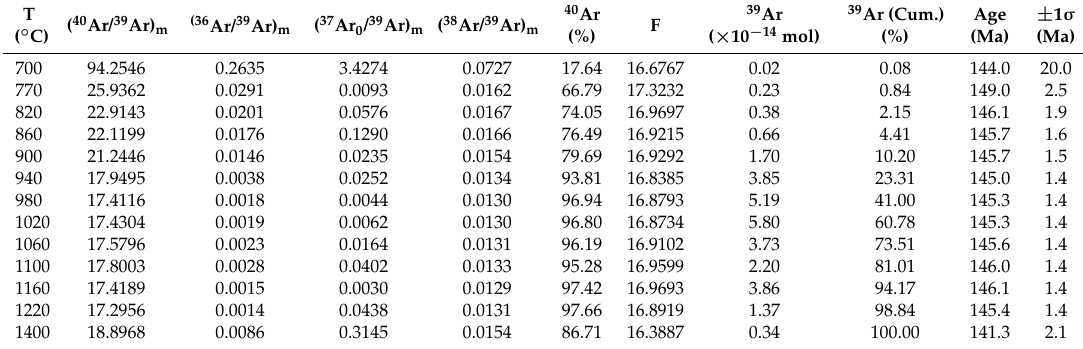
Table 1. 40 Ar/ 39 Ar analytical data for muscovite from the Shimensi tungsten deposit, South